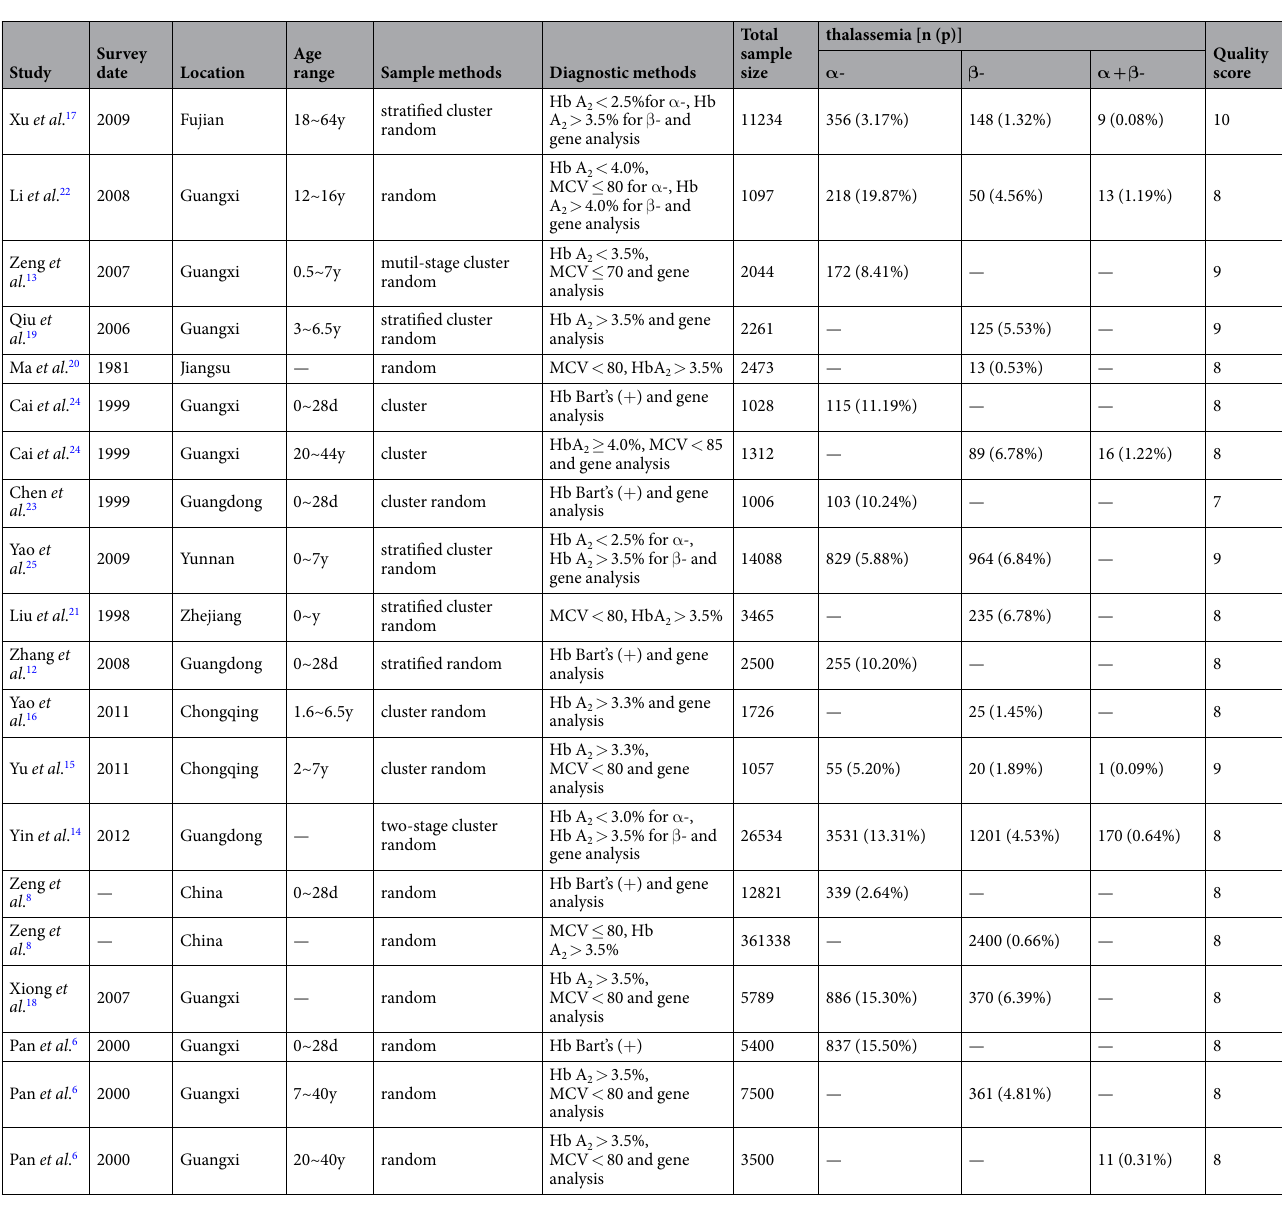
Table 1. The characteristics of the included